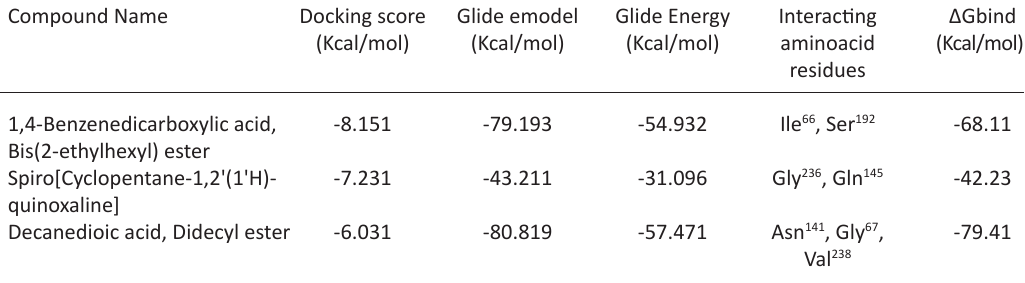
Fig. 2C. Molecular Docking of actinobacterially synthesized ligands with modeled SDR protein FOXG_00472 in Fusarium oxysporum f.sp. lycopersici ( FOL ). (A) 2D structure of FOXG_00472- Decanedioic acid, Didecyl ester complex showing the interacting aminoacid residues. (B) 3D structure of FOXG_00472 – ligands complex showing the interaction of Decanedioic acid, Didecyl ester at the active site of modeled SDR protein FOXG_00472 Table 3. Docking parameters analysed for the three antifungal lead compounds in Schrodinger